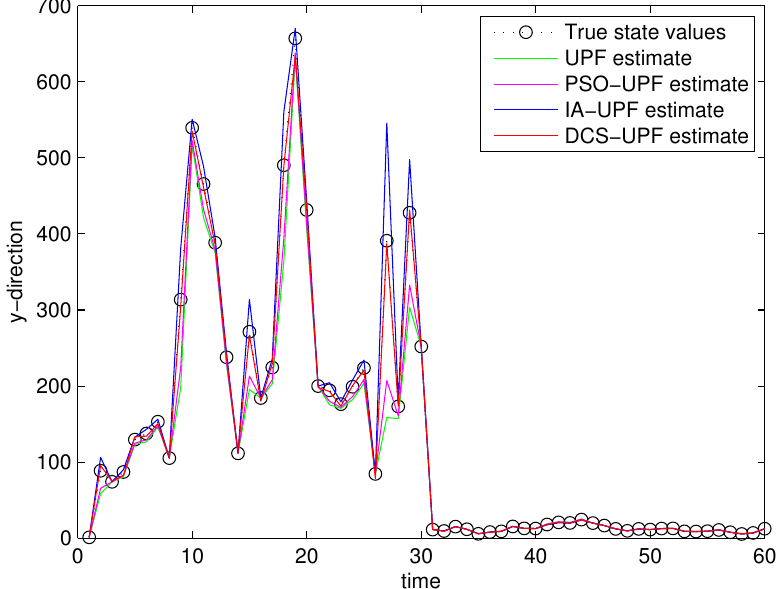
Figure 14. The target trajectory of UPF, PSO-UPF, IA-UPF, DSC-UPF in